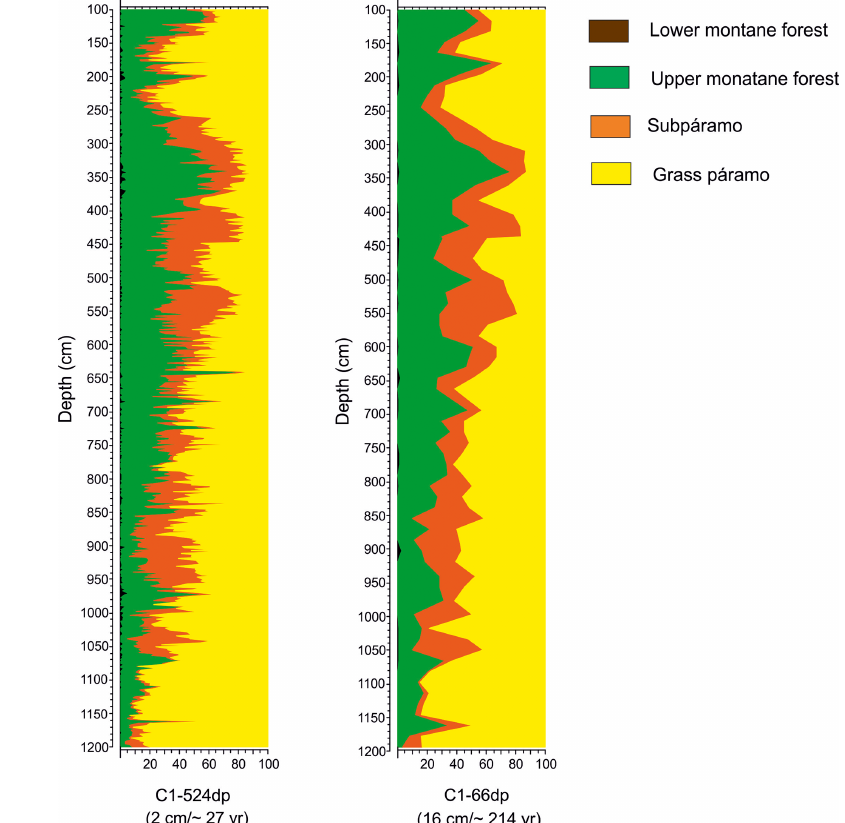
Figure 8. Pollen record from Lake La Cocha 1 (2780ma.s.l.; 12m long core) shows climate-driven altitudinal shifts of the main vegetation belts during the last 14kyr. Vegetation change is shown at 16cm sample distance (reflecting a ∼ 210-year resolution) and at 2cm sample distance (reflecting a ∼ 27-year resolution). Centennial-scale climate oscillations are evident at high resolution (figure courtesy of Zaire González